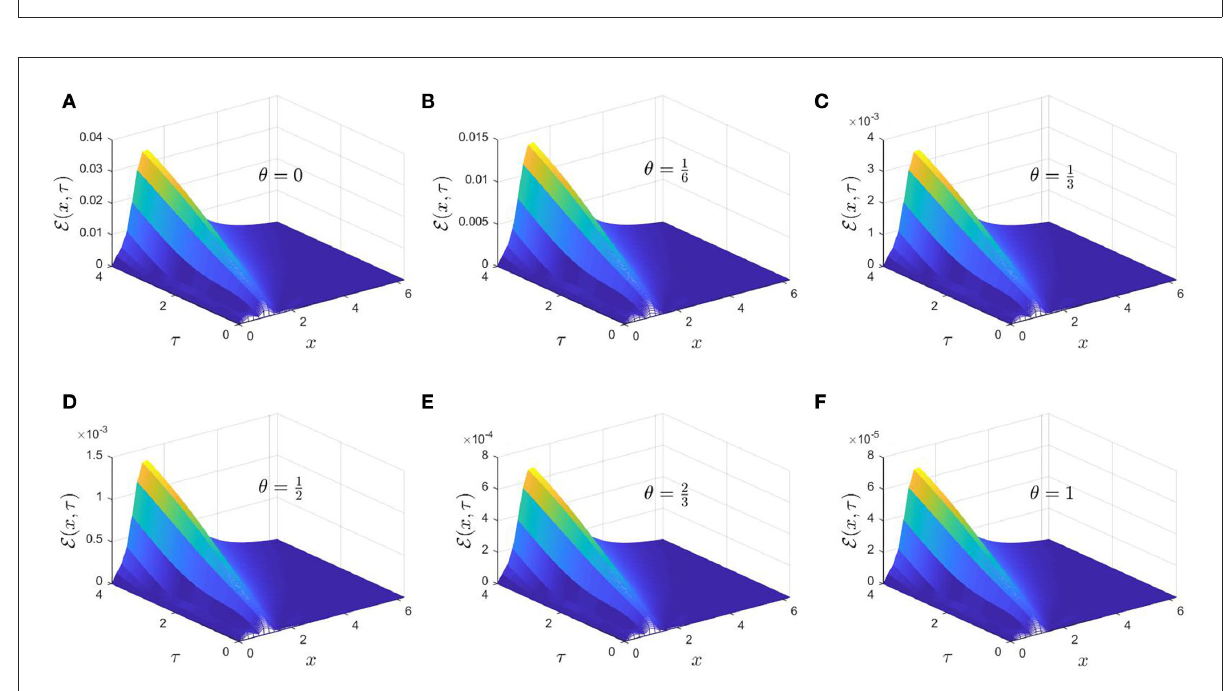
FIGURE1 (A–F) The numerical solutions of Example 1 for several values of θ